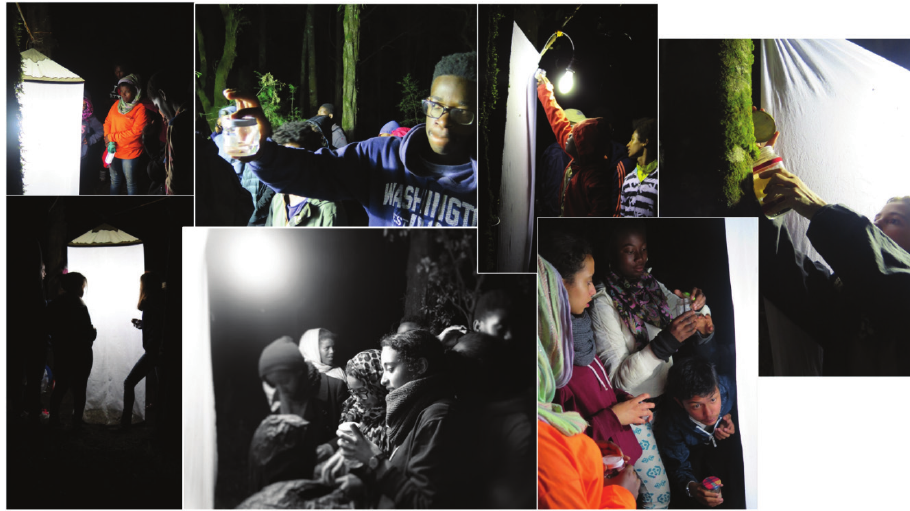
Figure 2. Pictures from the light-trapping session with two classes of the French High school Guebre- Mariam of Addis- Abeba (Seq#3). The students developed specific entomological skills from the different methods and recognised the choice of the trap needed to target a given insect. The students worked at night and respected safety procedure with toxic products (see killing jars) and finally were able to collect live insects manually. The second light trap technique (i.e. actinic lamp) is shown on the two left pictures while the manual light trap is shown on the four right-side